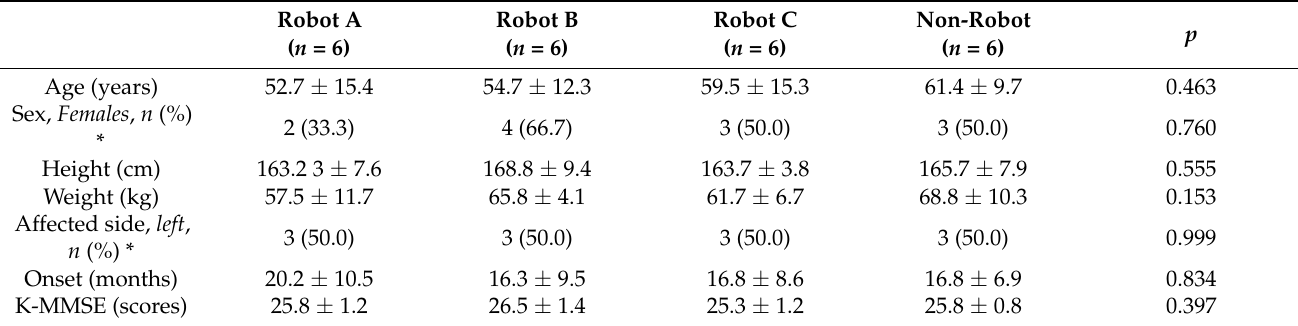
Table 1. General characteristics of participants ( N =